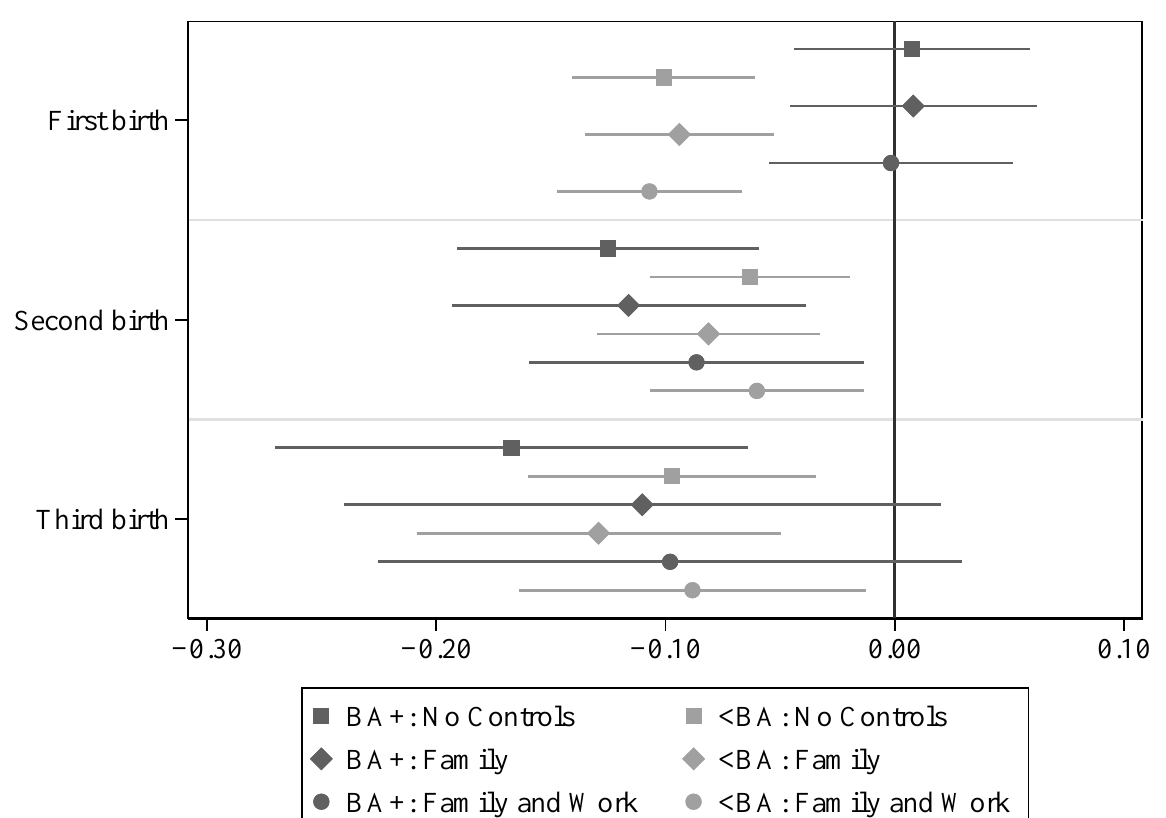
Figure 3: Coefficients across specifications, model 2: parity. Coefficient estimates are from model 2 in Table 2 (“No Controls”), Table 3 (“Family”), and Table 4 (“Family and Work”). BA, bachelor’s